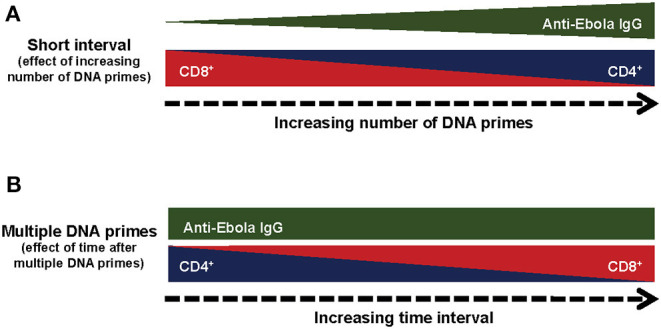
Summary of the immunological responses to different regiments of DNA prime rAd5-GP Boost. (A) Effect of the number of prime immunizations. (B) Effect of time after multiple DNA prime immunizations.